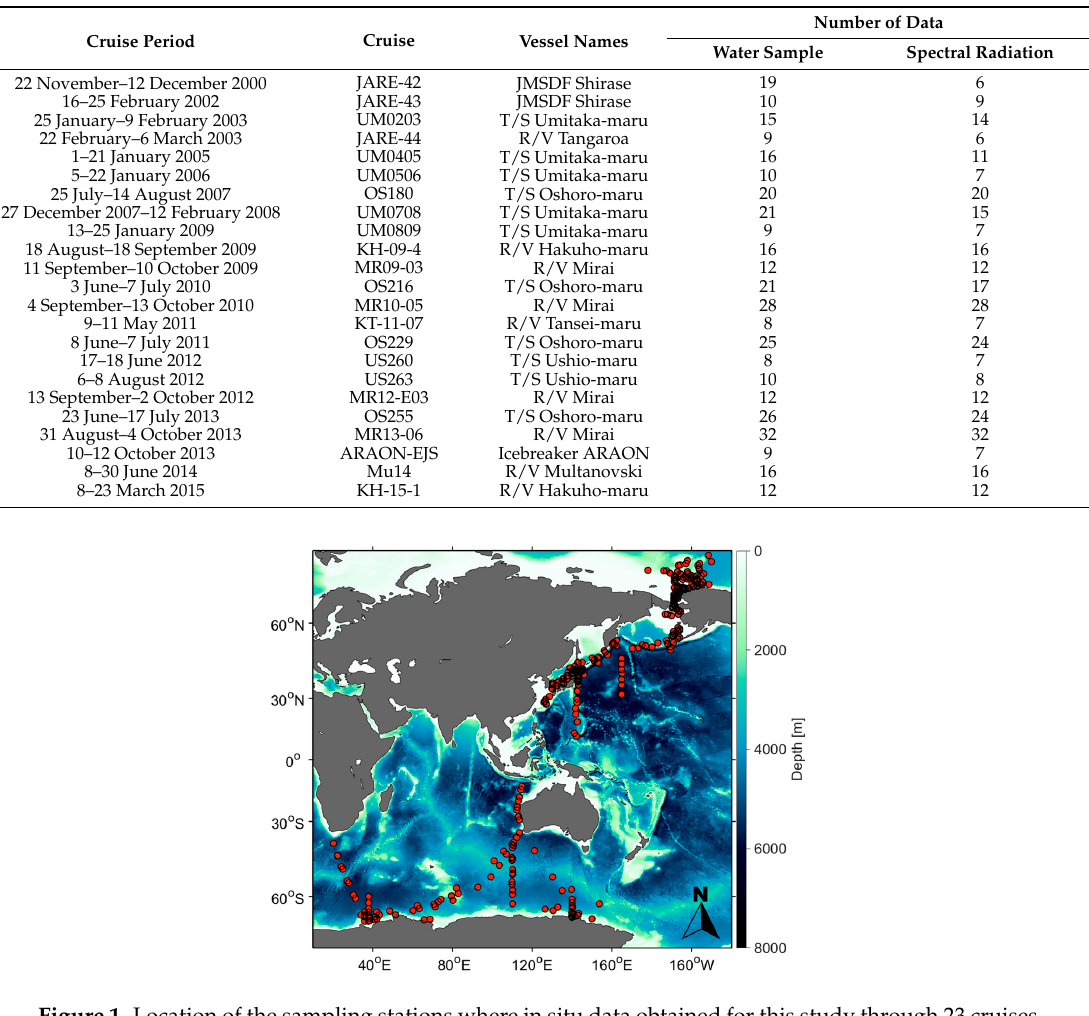
Figure 1. Location of the sampling stations where in situ data obtained for this study through 22 cruises over the period 2000–2015.